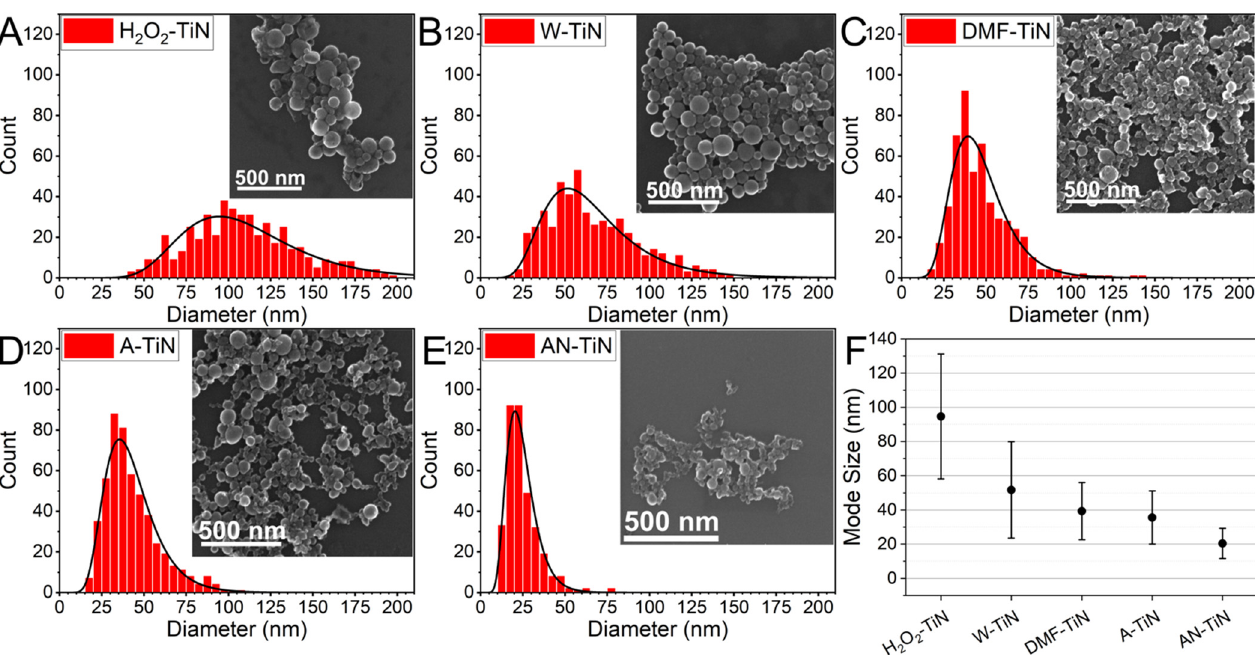
Figure 1. SEM characterization of NPs prepared by PLAL of TiN target in different liquids. ( A – E ) size histograms of H 2 O 2 -TiN, W-TiN, DMF-TiN, A-TiN, and AN-TiN NPs, respectively. Black curves are lognormal data fits. Insets demonstrate characteristic SEM images of the NPs. ( F ) Mode size of the lognormal fits of size distribution of NPs prepared in different liquids. Error bars represent distribution widths.